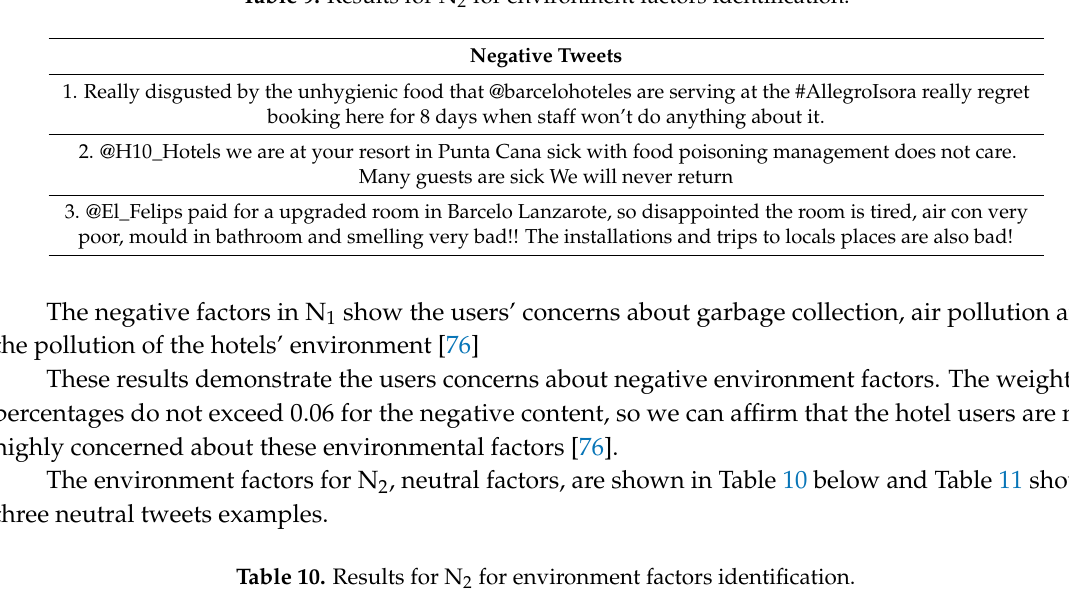
Table 9. Results for N 2 for environment factors identification.